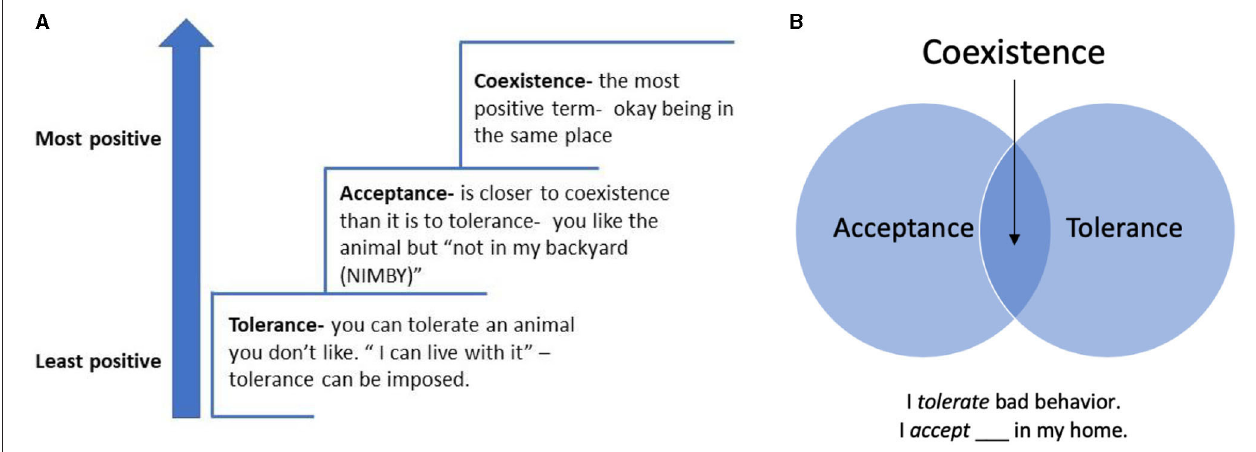
FIGURE 1 | (A,B) Examples of how participants viewed tolerance, acceptance, and coexistence in relation to one another: increasingly positive valence from tolerance to acceptance to coexistence (A) and as same level of valence (B)